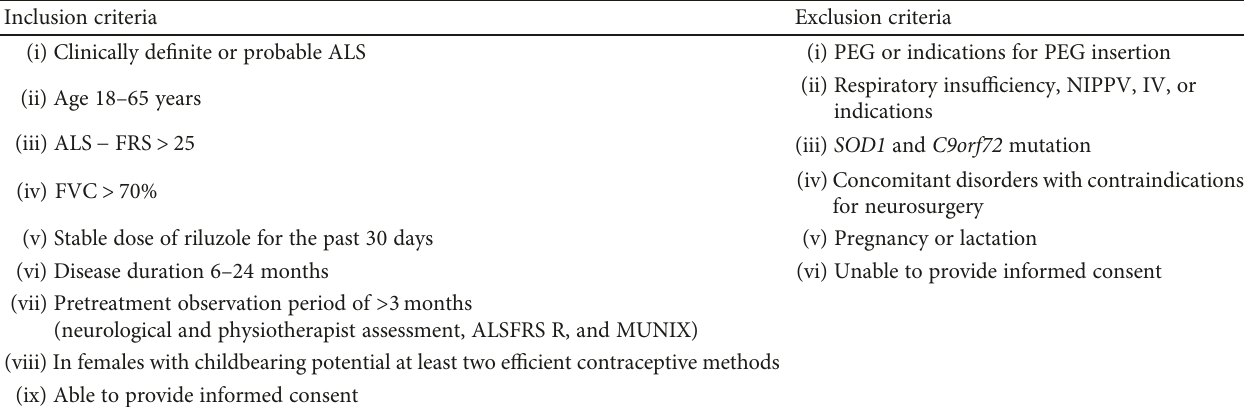
Table 1: Inclusion and exclusion criteria for the intraspinal and intrathecal ADRC transplantation. Inclusion